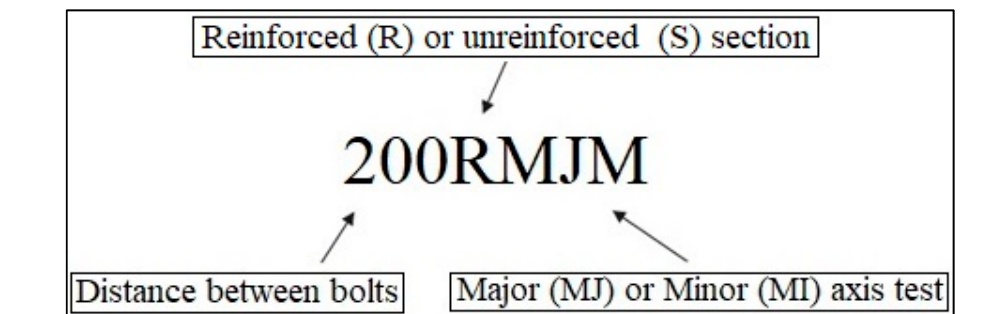
Figure 3. Designation of specimens.